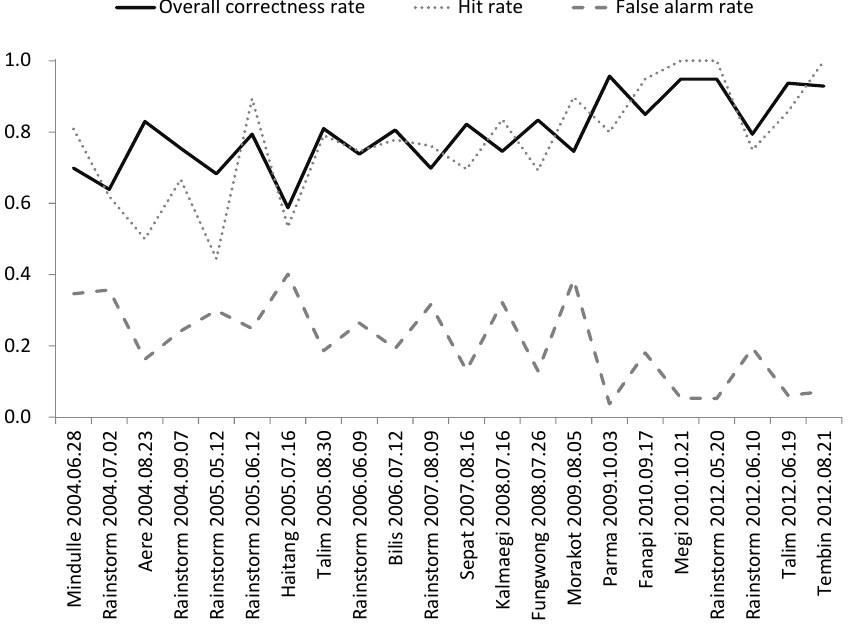
Figure 7. Variation of warning performance with rainfall